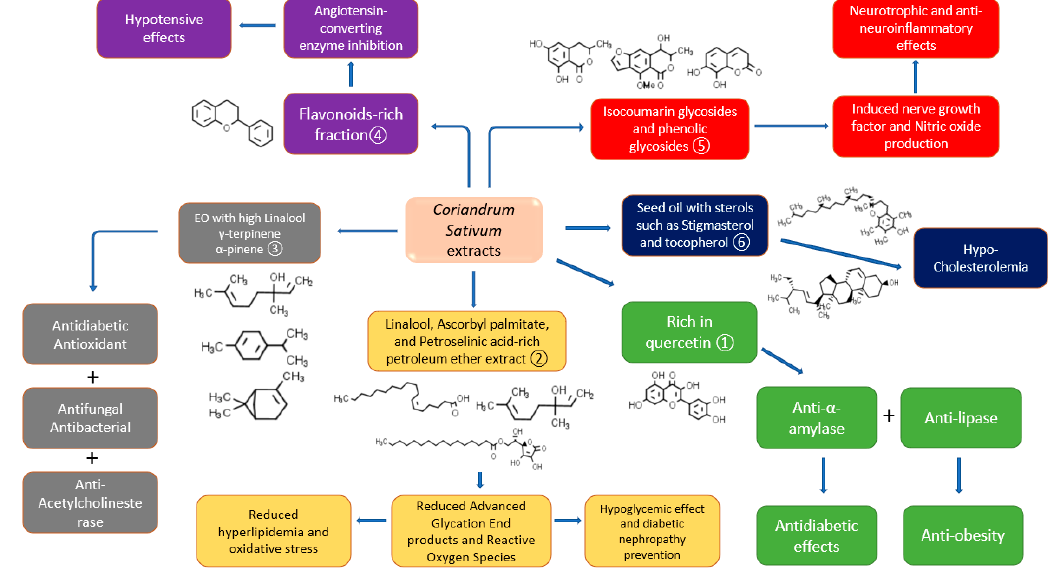
Figure 4. The role of C. sativum phytochemicals in some of its biological activities from